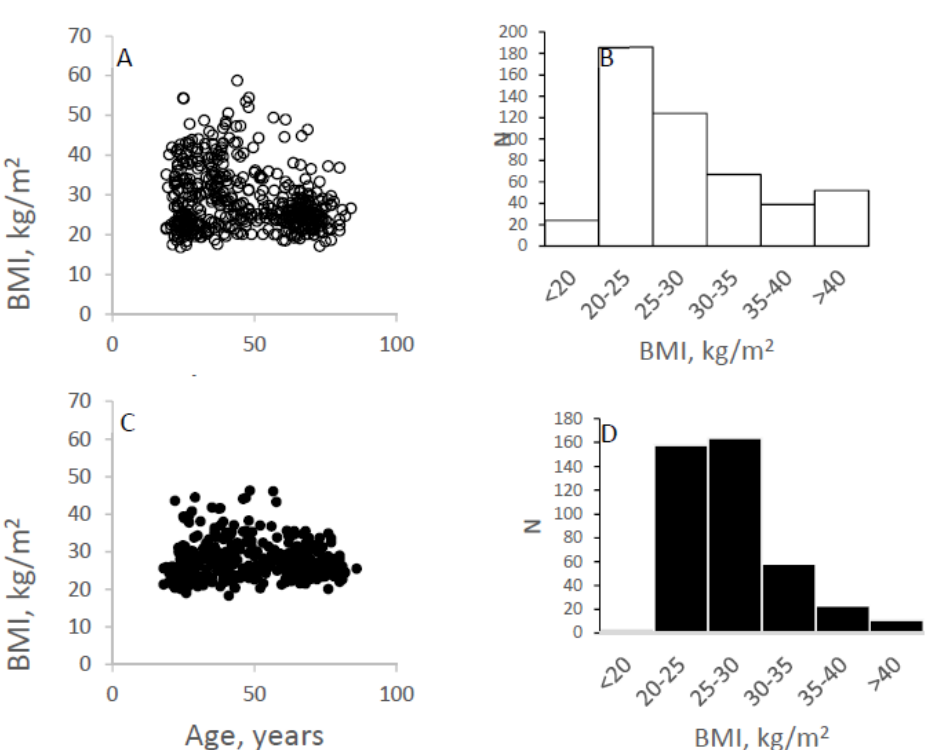
Figure 1. BMI with age in females ( A ) and males ( C ) and the distribution of BMI groups according to BMI categories (<20, 20–25, 25–30, 30–35, 35–40 and >40 kg/m 2 ) in females ( B ) and males ( D ), respectively, in the ‘Kiel study population’: n = 908 subjects; 54% females and 46% males; age range of 18 to 86 yrs.